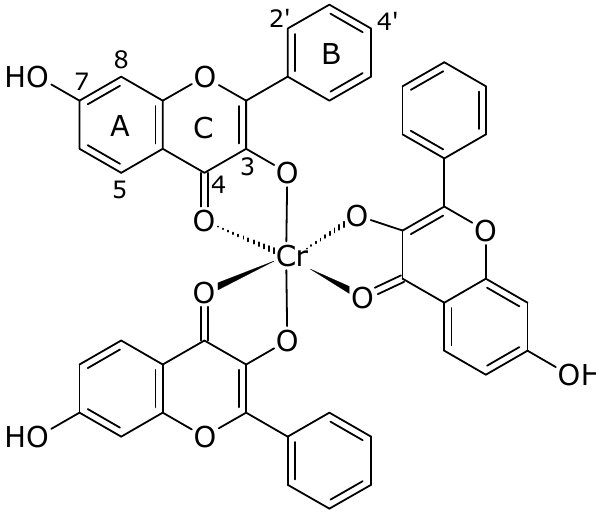
Figure 4. Schematic representation of the complex [Cr(3,7-diHF) 3 ].